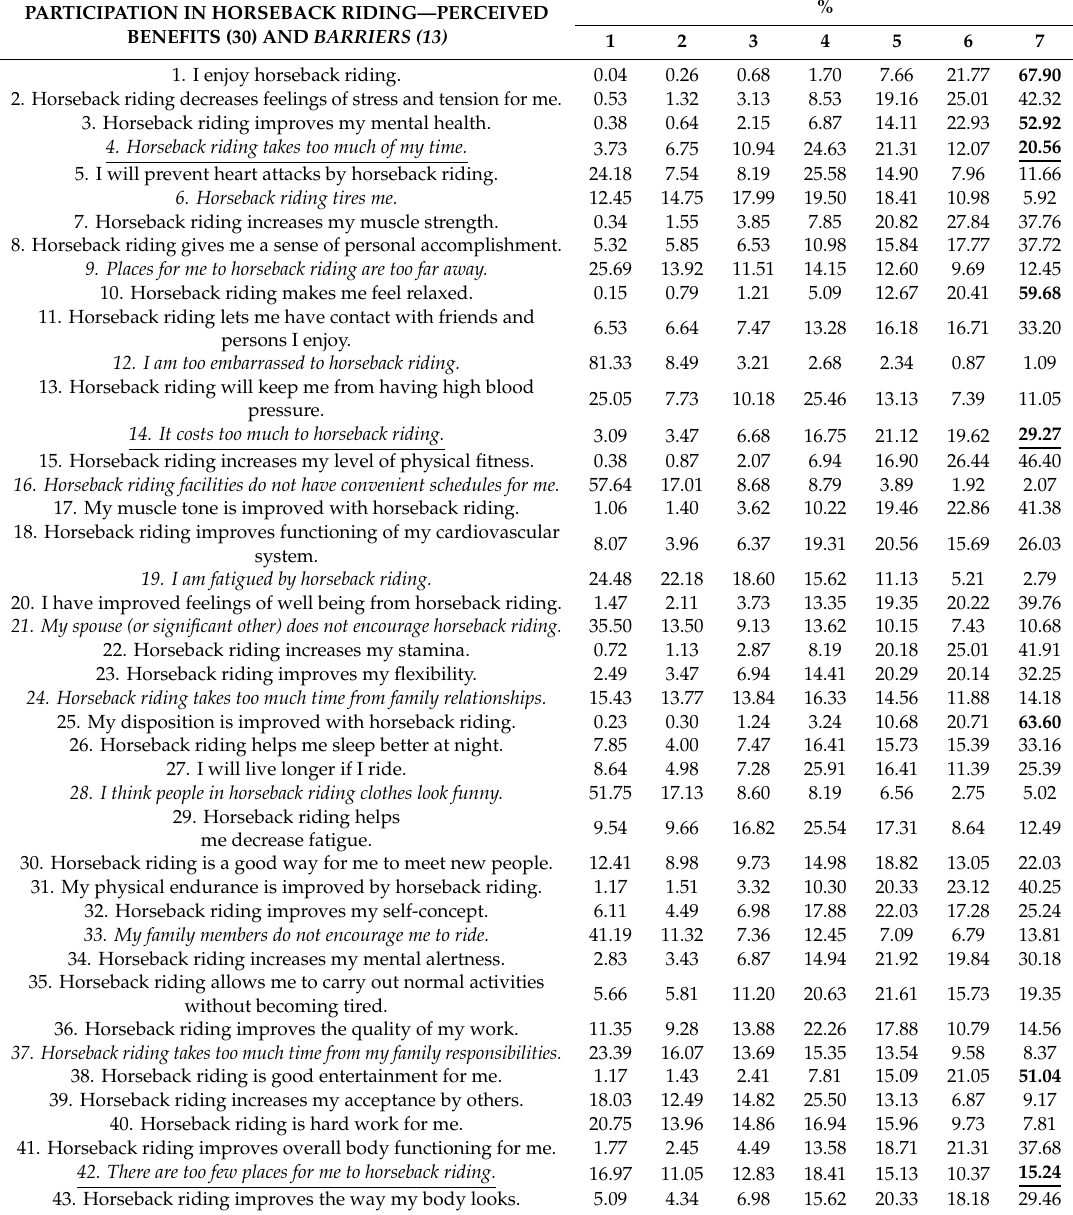
Table 2. The percentage distribution of answers given by all respondents (n = 2651) in the range 1–7 Likert scale (1—this issue concerns me to a very low degree; 7—this issue concerns me to a very high